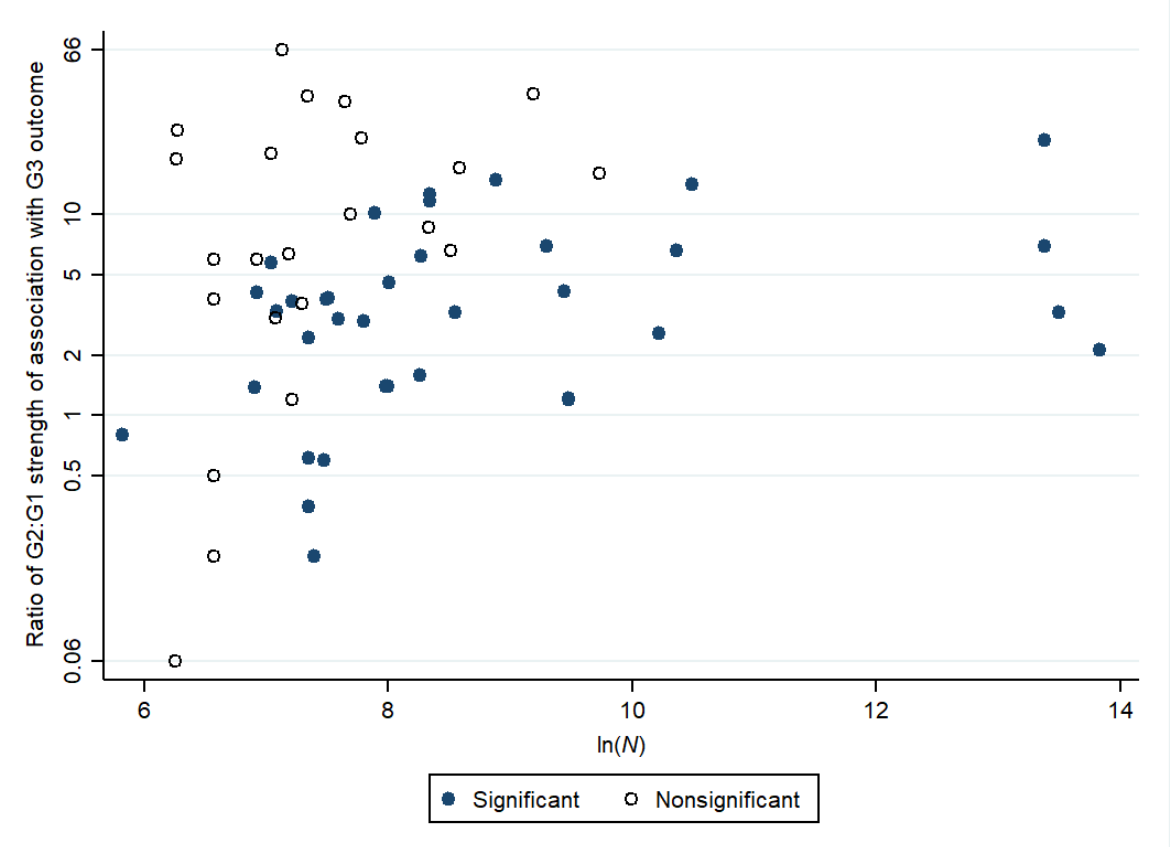
Figure 4: Ratio of G2:G1 (parent to grandparent) strength of association with G3 (grandchild) outcome by ln( N ) and whether estimates are significant. N = 59. Note : Each point corresponds to an analysis. A larger number on the y axis corresponds to a stronger G2–G3 association relative to the G1–G3